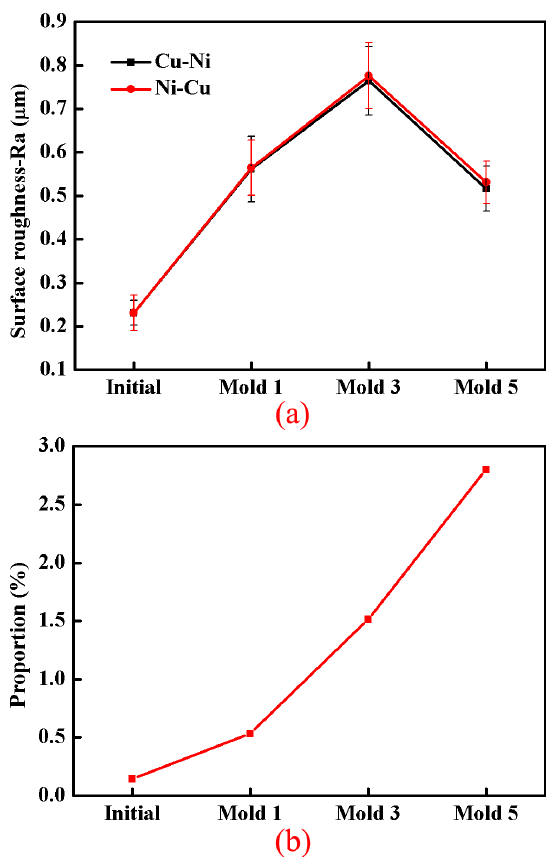
Figure 12. ( a ) The feature size effect on surface roughness; ( b ) The feature size effect on difference degree of surface roughness between two different layer stacking sequences.